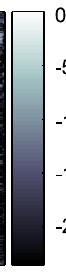
FIG. 8. Tissue (T), contrast (C), and artifact (A) regions of interest used for the ratios displayed in Fig. 6.